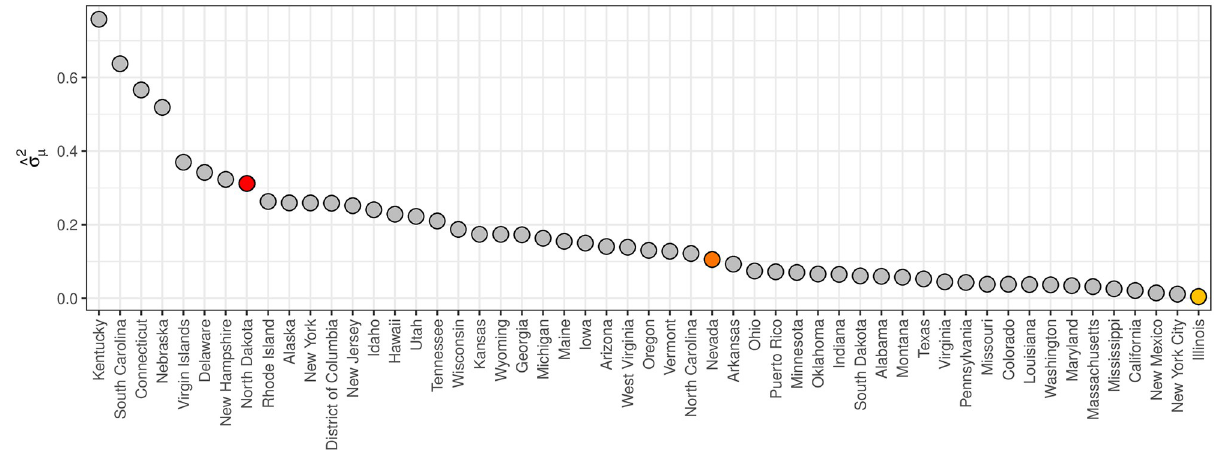
Fig 8. ^ s 2 for all states. Considerable variation in ^ s 2 m